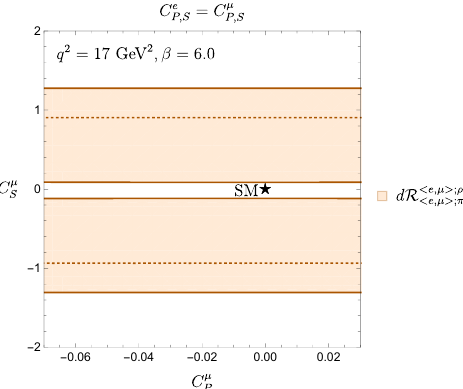
µ µ – C plane following from the observable d R P S